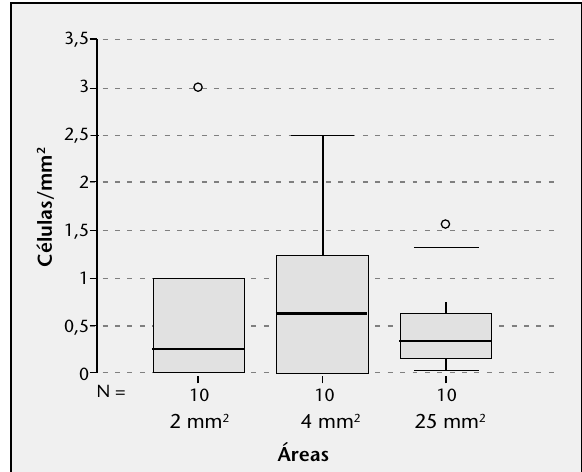
Figura 5 – Teste de validação do TMA: antígeno Ki-67 Teste do sinal TMA: tissue microarray